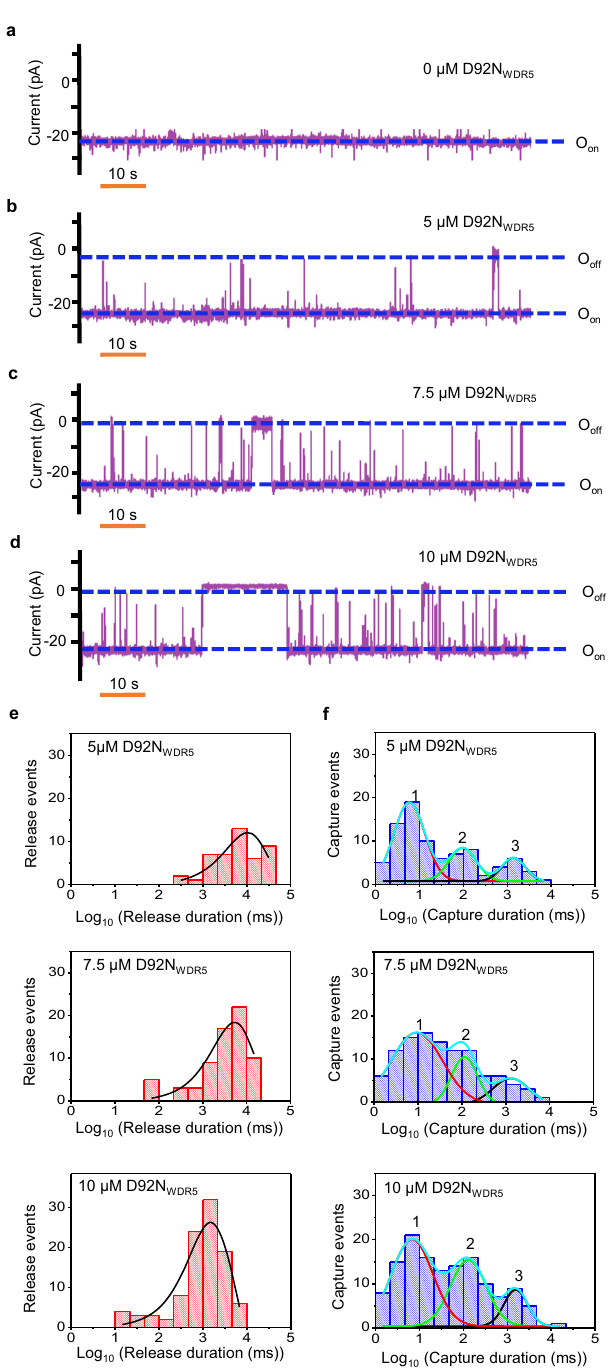
Fig. 4 Real-time detection of weakly binding D92N WDR5 . a A single- channel electrical trace of MLL4 Win tFhuA. b MLL4 Win tFhuA with 5 μ M D92N WDR5 . c MLL4 Win tFhuA with 7.5 μ M D92N WDR5 . d MLL4 Win tFhuA with 10 μ M D92N WDR5 . O on and O off are release and capture substates, respectively. This single-channel electrical signature was replicated in three independent experiments. Single-channel electrical traces were low-pass fi ltered at a frequency of 100Hz using an 8-pole Bessel fi lter. e Histograms of D92N WDR5 - released durations ( τ on ) at 5 μ M, 7.5 μ M, and 10 μ M D92N WDR5 . τ on durations (mean±s.e.m.) were 9.1±3.4s (number of events: N = 45), 4.9±1.0s ( N = 69), and 2.2±0.8s ( N = 101), respectively. f Histograms of D92N WDR5 - captured durations ( τ off ). The cumulative fi ts are marked in cyan. The red, green, and black curves indicate fi ts of τ off-1 , τ off-2 , and τ off-3 for short-, medium-, and long-lived D92N WDR5 -captured events, respectively. For 5 μ M D92N WDR5 , they (mean±s.e.m.) were 0.008±0.001s, 0.13±0.01s, and 1.6±0.1s, respectively (number of events: N = 78). For 7.5 μ M D92N WDR5 , they were 0.010±0.001s, 0.12±0.01s, and 1.9±0.1s, respectively ( N = 106). For 10 μ M D92N WDR5 , they were 0.009±0.001s, 0.19±0.01s, and 1.8±0.1s, respectively ( N = 120). Data was extracted from 20min recordings. Source data are provided as a Source Data fi